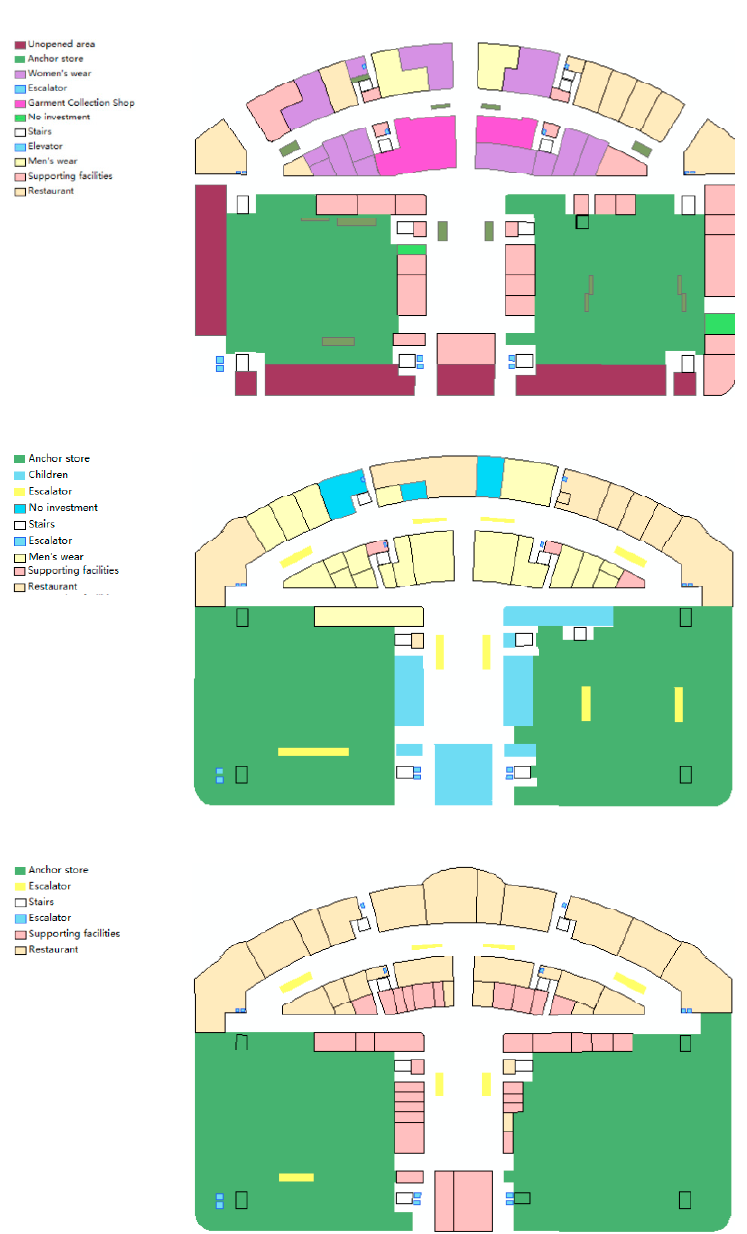
Figure 1. Distribution of stores in the shopping mall (floors 1, 2, and 3).